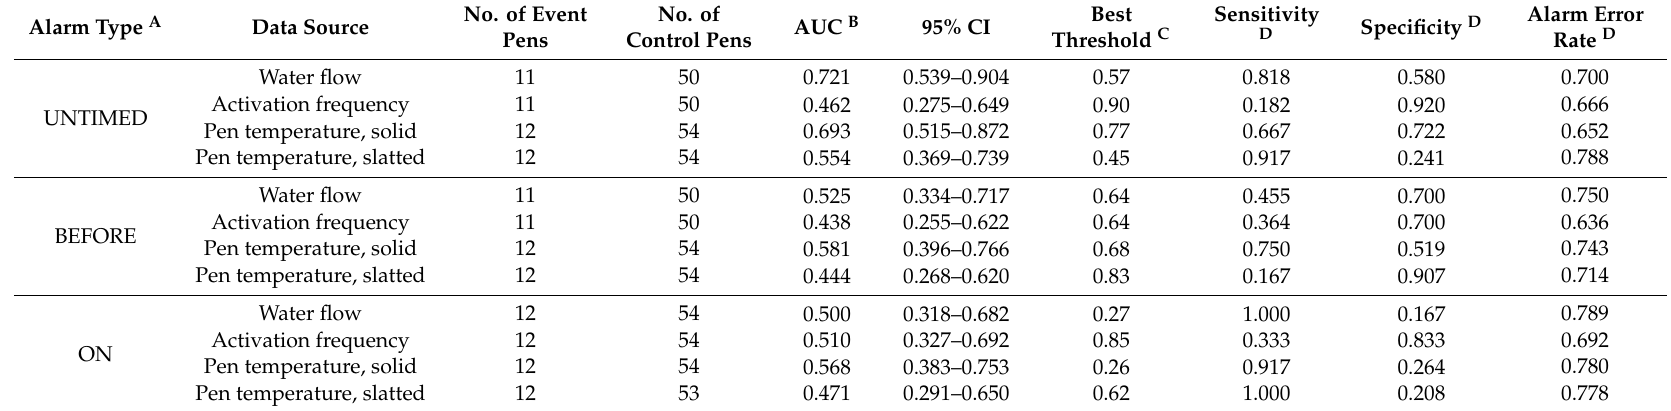
Table 1. Predictive performance of the artificial neural networks trained and optimised for each data source and alarm